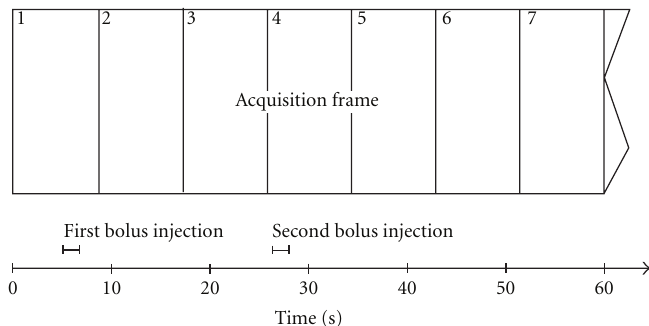
Figure 1: Timing of image acquisition: there is a 21s (exactly 2.5 times the acquisition time frame) interval between start of the first and second bolus application. The solid and dashed lines schematize the contrast agent volume in the arterial and venal vessels. In the depicted case the second bolus would yield optimal contrast (see Figure 2 bottom